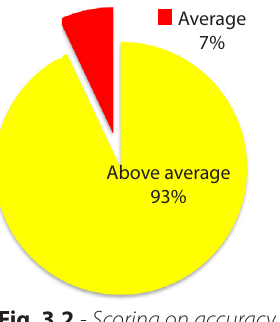
Fig. 3.3 - Scoring on heart model for treatment planning (n=30).